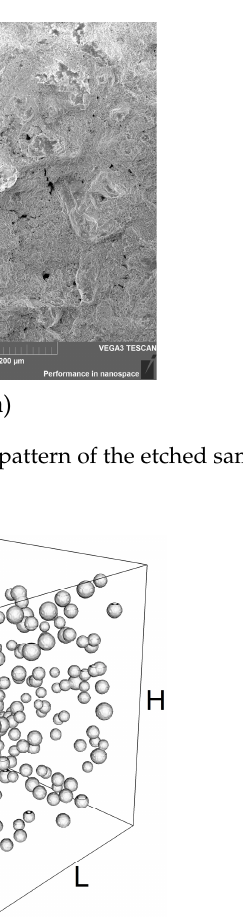
Figure A1. Method for determination of Young’s modulus and Poisson’s ratio of sample ( a ), schematic experimental setup, 1—sample, 2—force gauge, 3—vertical strain gauge, 4—lateral strain gauge, 5—loading plates, 6—3-channel amplifier, 7—analog to digital converter ( b ).